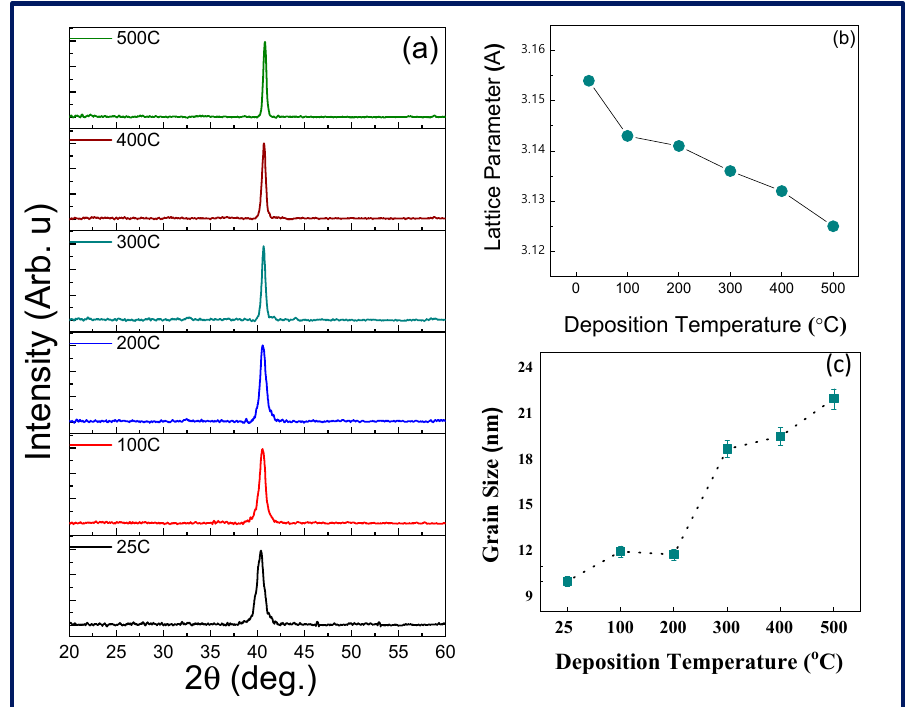
Figure 1. ( a ) θ /2 θ X-ray diffraction patterns of Mo films deposited at different temperatures. The (110) peak is the only peak observed; the peak intensity increases with increasing deposition temperature. The broader peak for Mo films deposited at 25–200 ◦ C indicates the very small crystallite size. ( b ) The lattice parameter variation with deposition temperature. The lattice parameter increase at lower temperatures is primarily due to nanoscale effects. ( c ) The variation of average crystallite size with deposition temperature. It is evident that the average crystallite size increases with increasing deposition